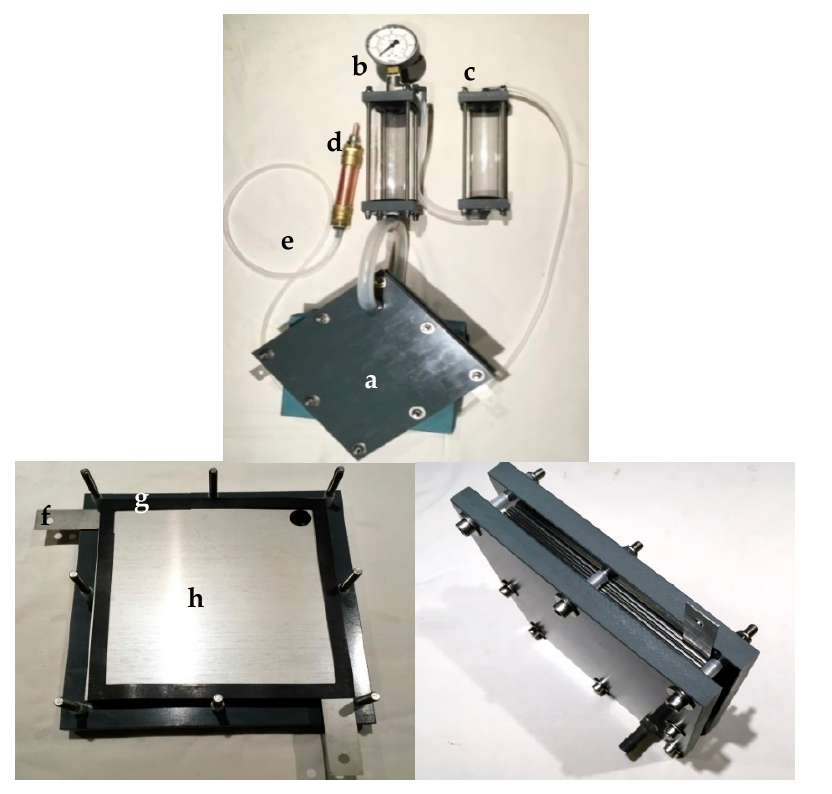
Figure 2. The dry cell system used in this work: ( a ) Dry cell, ( b ) Reservoir with Manometer, ( c ) Bubbler, ( d ) Arrestor, ( e ) Hoses, ( f ) Poles, ( g ) Sealing rings, ( h ) Stainless steel plates–electrodes.